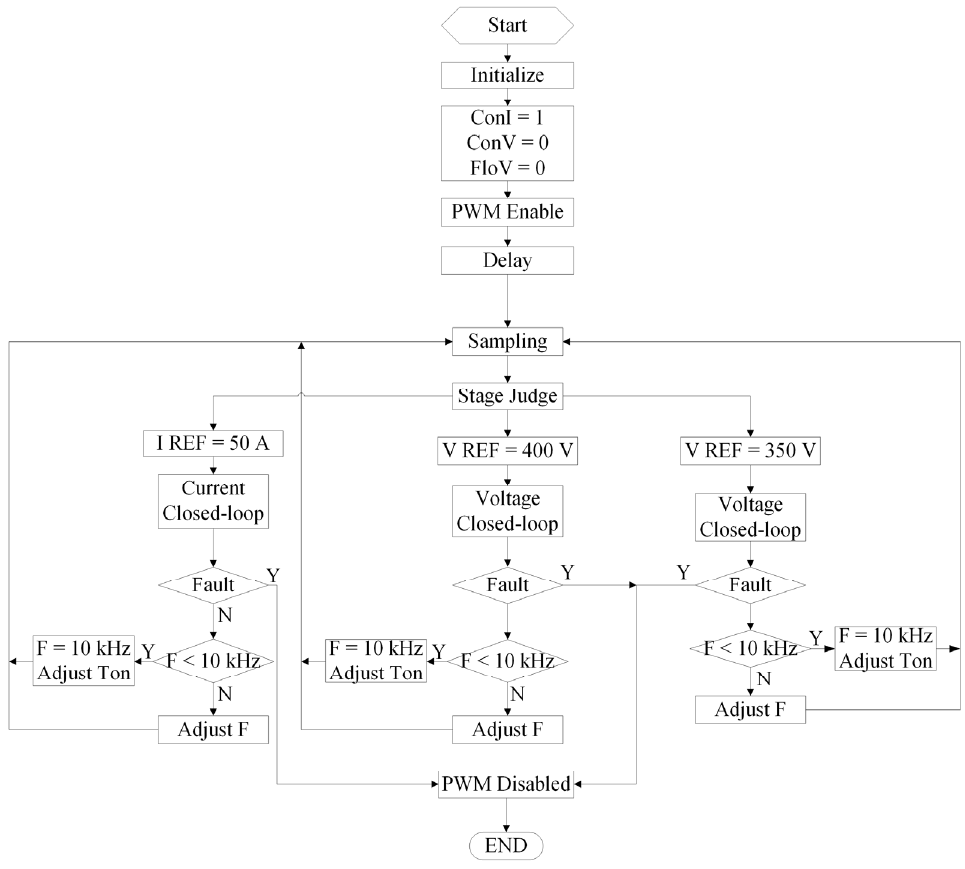
Figure 14. Charging process control flow chart.